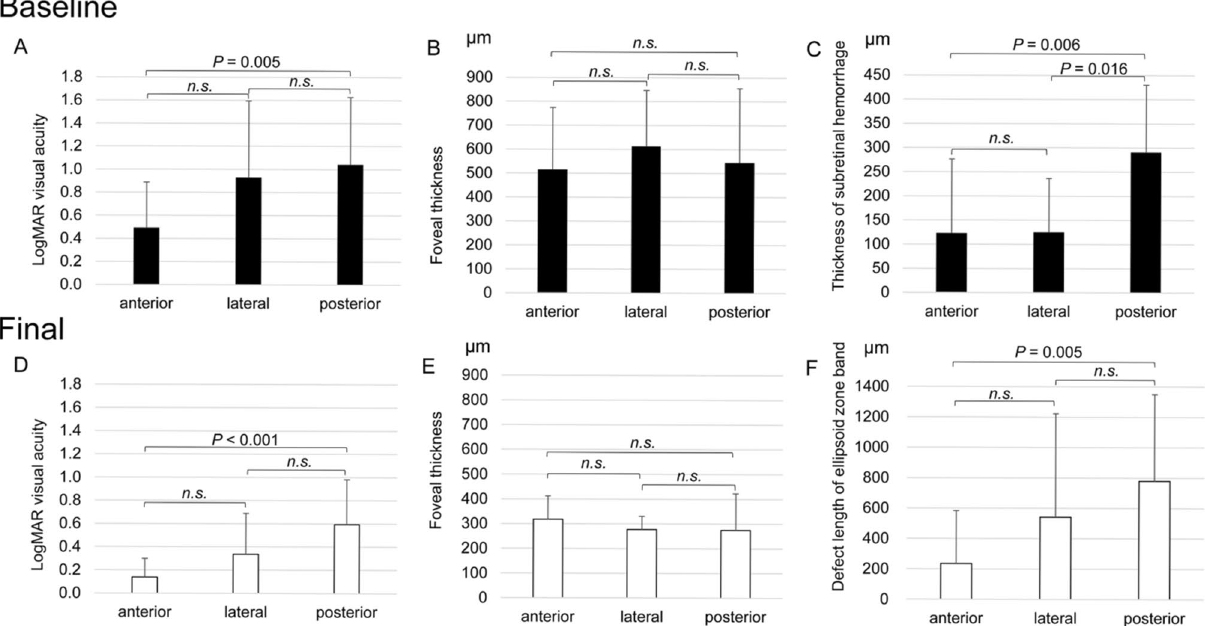
Figure 2. Baseline and final foveal function and morphology according to the position of ruptured retinal arterial macroaneurysms relative to the affected artery. ( A , B , C ) Baseline findings. ( D , E , F ) Final findings. ( A , D ) Logarithm of the minimum angle of resolution (LogMAR) visual acuity (VA). ( B , E ) Retinal thickness at the fovea. ( C ) Thickness of subretinal hemorrhage at baseline. ( F ) Length of the ellipsoid zone band defect. VA and the subretinal hemorrhage thickness at baseline are poorer and greater, respectively, for patients with ruptured retinal arterial macroaneurysms (RMAs) located posterior to the affected artery (posterior type) than for patients with ruptured RMAs located anterior to the affected artery (anterior type). At the final visit, the length of the foveal ellipsoid zone band defect is greater and the final VA is poorer for patients with the posterior